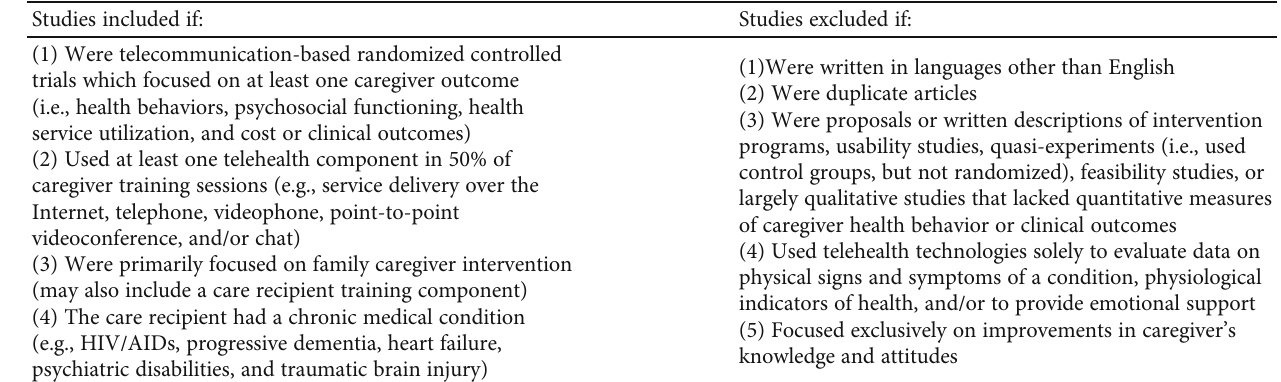
Table 2: Inclusion and exclusion criteria for article selection.